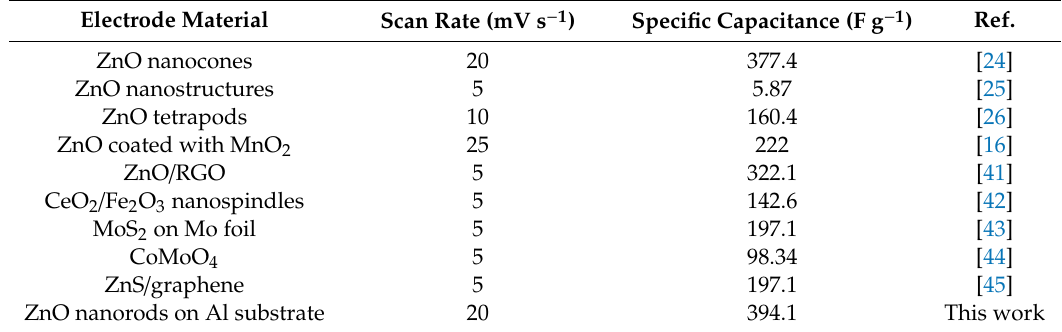
Table 1. A comparative study of specific capacitance between current work and earlier